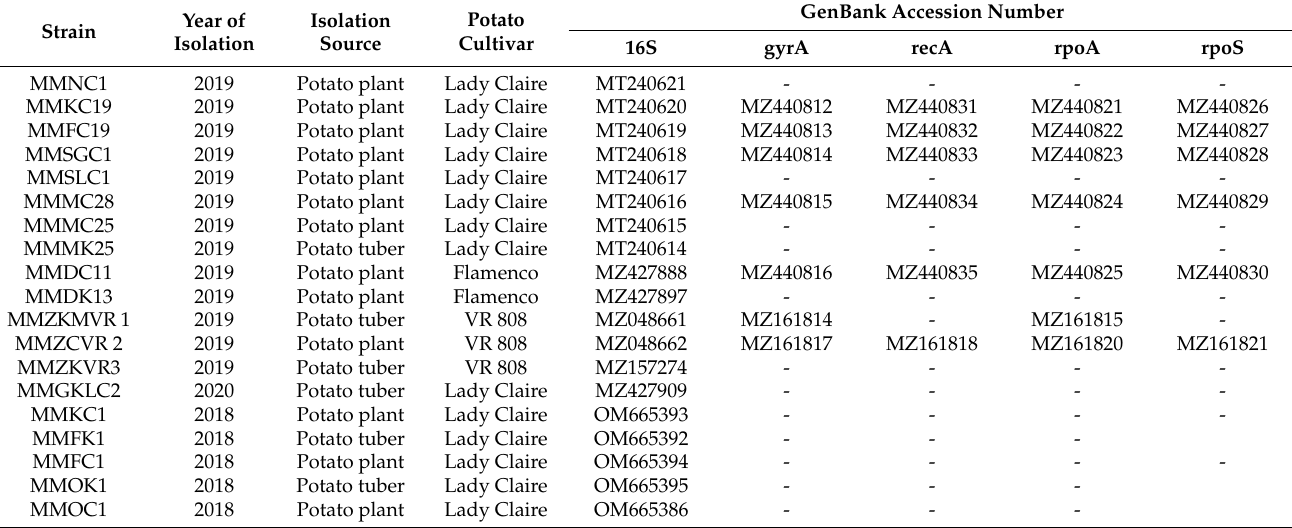
Table A1. The list of Pectobacterium strains obtained in this